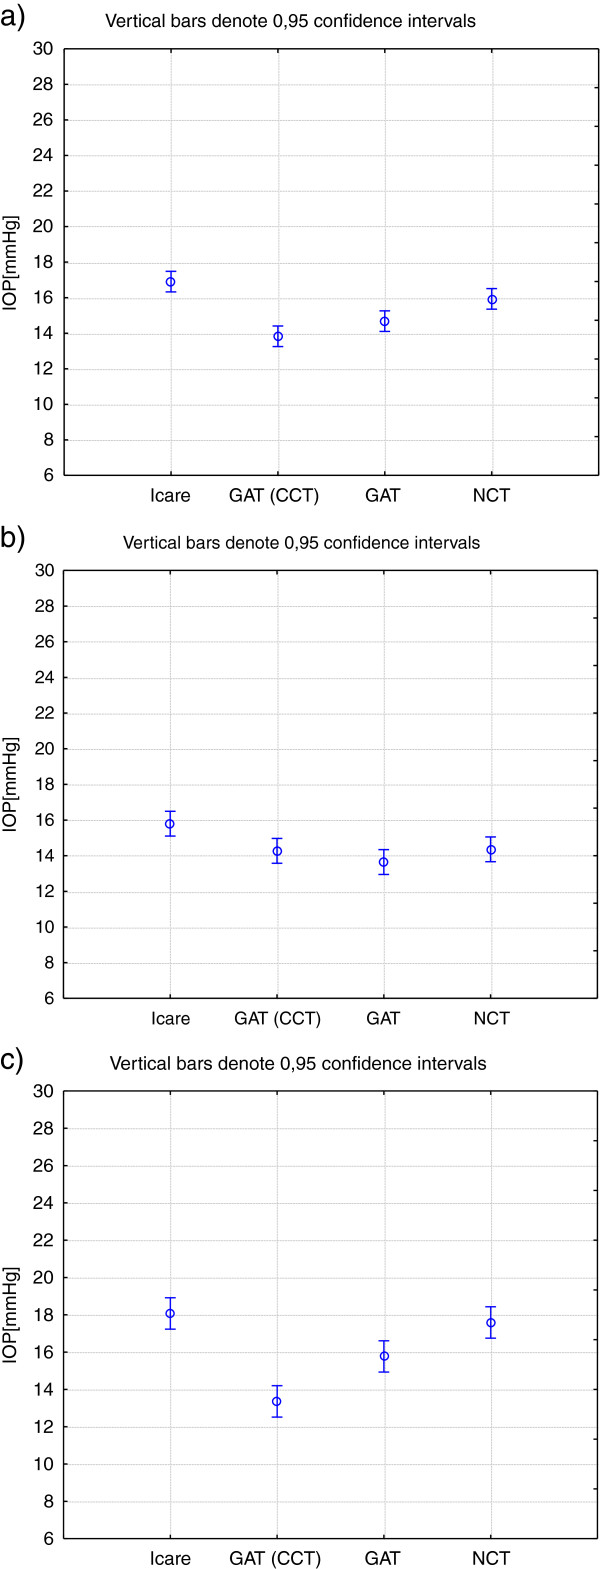
Confidence intervals for intraocular pressure values (IOP) (mmHg) obtained with the ICare tonometer, Goldmann applanation tonometer (GAT) corrected and uncorrected and the non-contact tonometer (NCT) for a) the entire cohort; b) subgroup with CCT <563 μm; c) subgroup with CCT ≥ 563 μm.